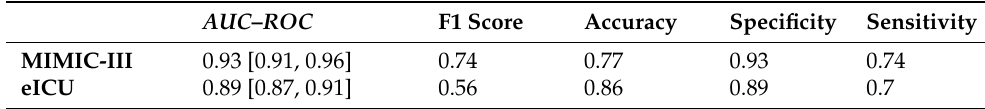
Table 5. External validation of a predictive model for early mortality in patients with VTE based on a signature of 35